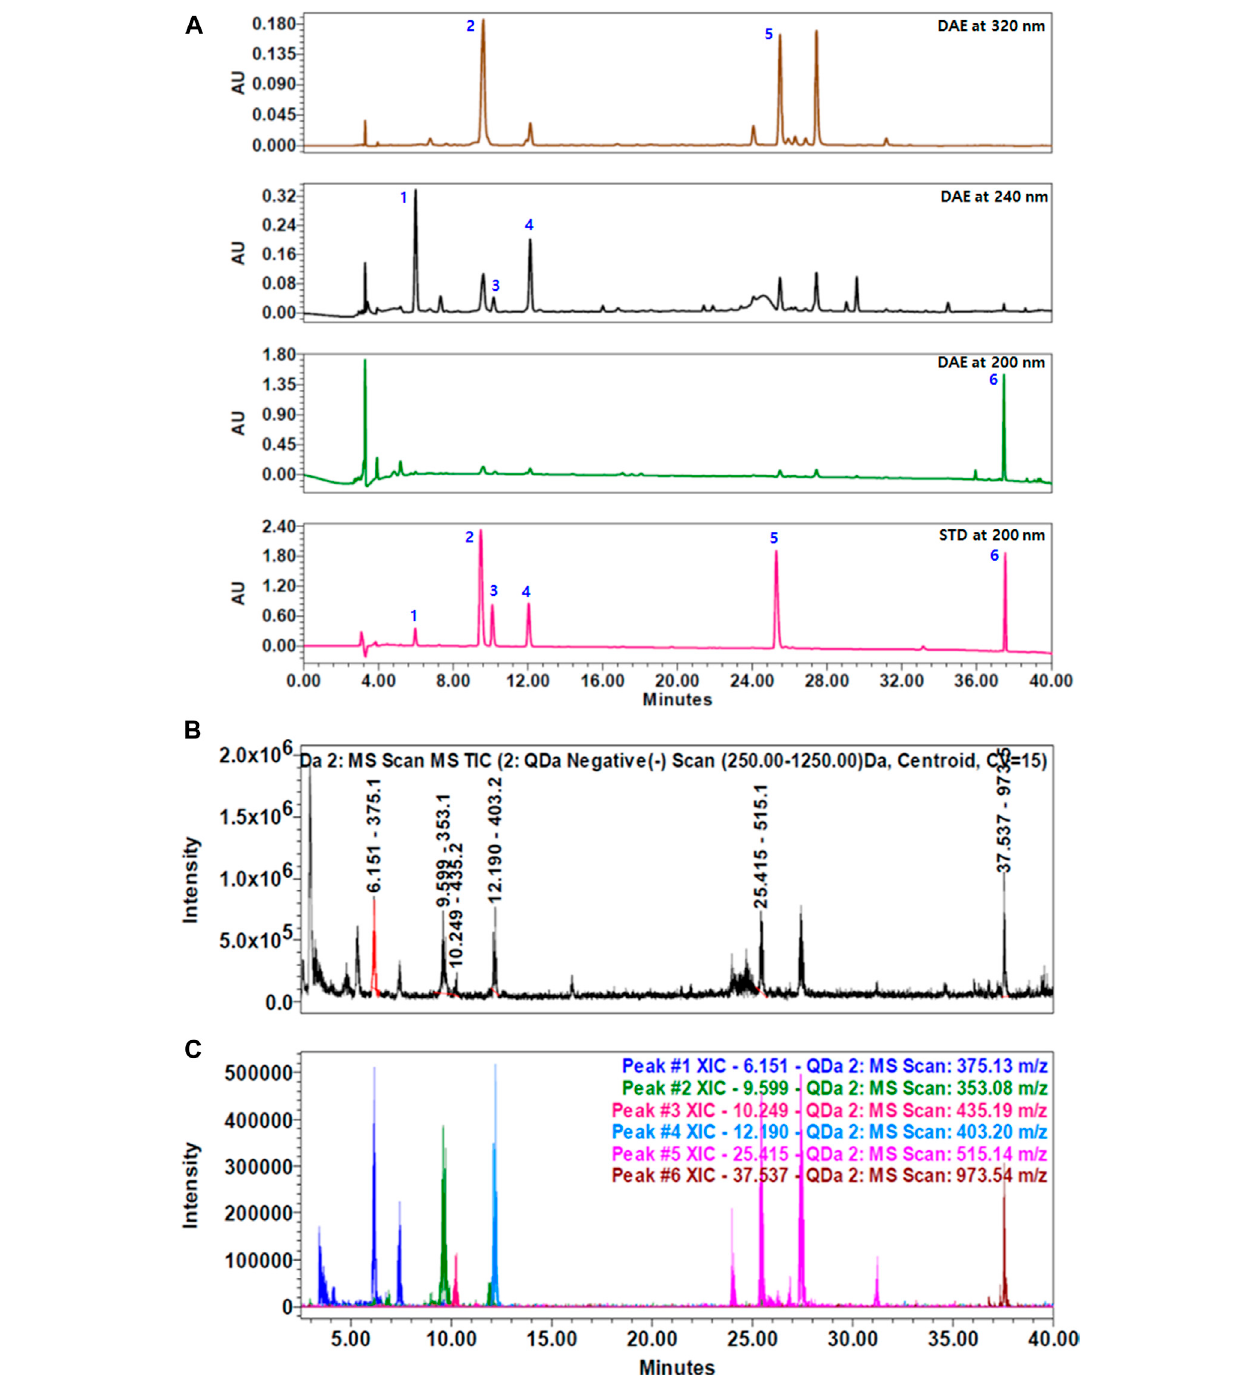
FIGURE1| HPLCchromatogramsof Dipsacusasperoides ethanolicextract(DAE). (A) ChromatogramsofDAEanalyzedbyHPLC – PDAat200,240,and320 nm. 1)Loganicacid,2)chlorogenicacid,3)loganin,4)sweroside,5)isochlorogenicacid,and6)akebiasaponinD. (B) Totalioncurrent(TIC)chromatogramand (C) extracted ion chromatogram (XIC) of the DAE compounds analyzed by HPLC – MS. MS values ( m/z ) in negative mode of mass spectrum were con fi rmed as follows: loganic acid [M − H] - (cid:2) 375.13,chlorogenicacid[M − H] - (cid:2) 353.08,loganin[M+COOH − ] - (cid:2) 435.19,sweroside[M+COOH − ] - (cid:2) 403.20,isochlorogenicacidA[M − H] - (cid:2) 515.14, and akebia saponin D [M + COOH − ] - (cid:2) 973.54.